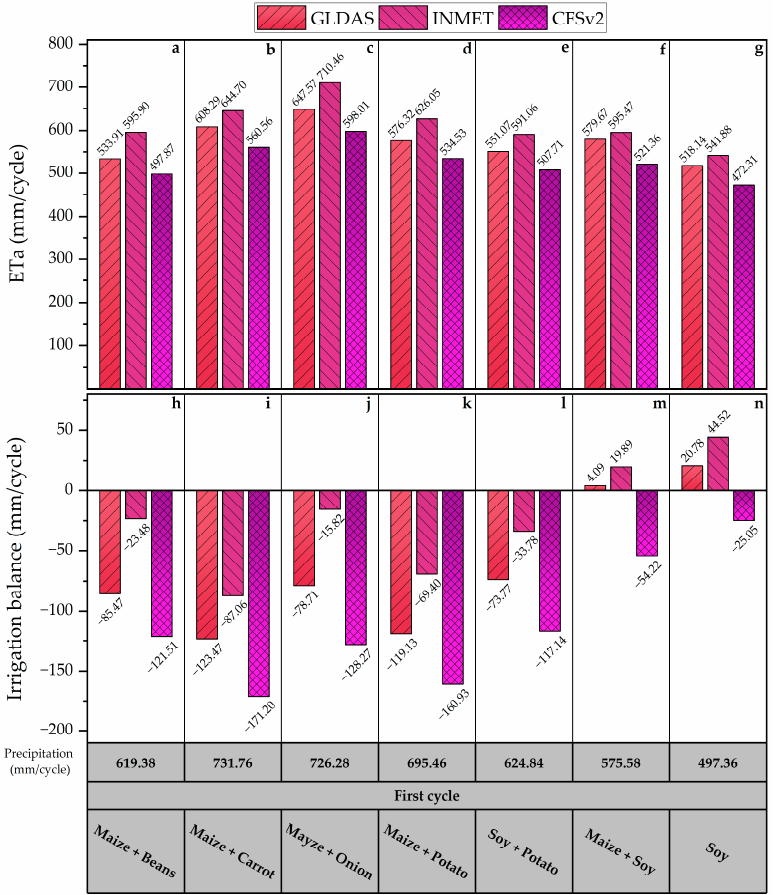
Figure 10. Average accumulated evapotranspiration ( a – g ), precipitation, and the irrigation balance ( h – n ) of the first cycle of the classes ( a – n ). The first cycle of the classes is mainly represented by the maize crop. The soy crop in the first cycle is observed in two classes, soy + potato and soy. The accumulated precipitation values are represented in the first row of the table below the graphs. As observed in Figure 10, the average accumulated ETa value for the maize class (first cycle of the double crop) was 542.5 mm for CFSv2 data, 589.2 mm for GLDAS, and 634.5